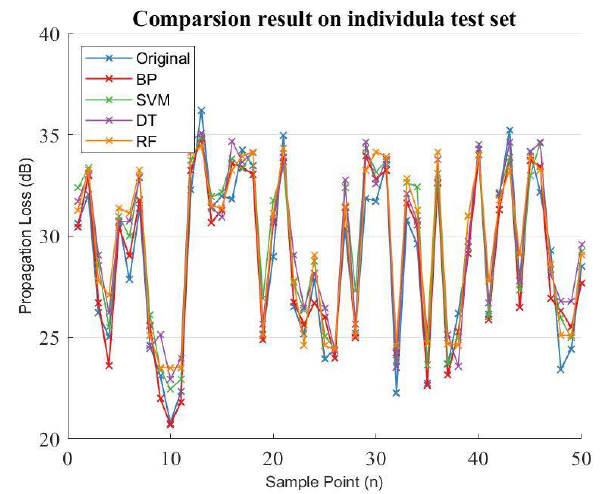
Figure 14. Comparison results of prediction performance of all prediction approaches. The x axis means different sample, the y axis is the corresponding propagation loss.